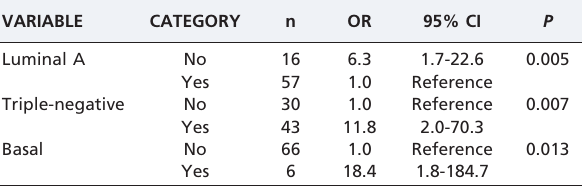
Table 5 - Evaluation of the mortality risk within 120 months a according to the luminal A, triple-negative and basal phenotypic patterns using multivariate analysis (logistic regression). Models were individually adjusted by age, hormone therapy and adjuvant chemotherapy (number of deaths considered in the model =